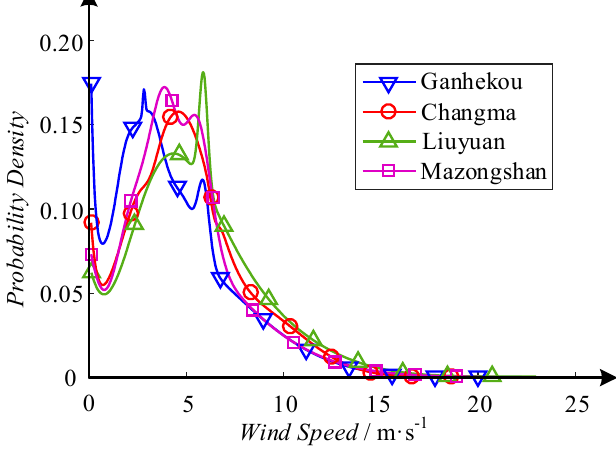
Figure 5. Wind speed PDFs of four areas.